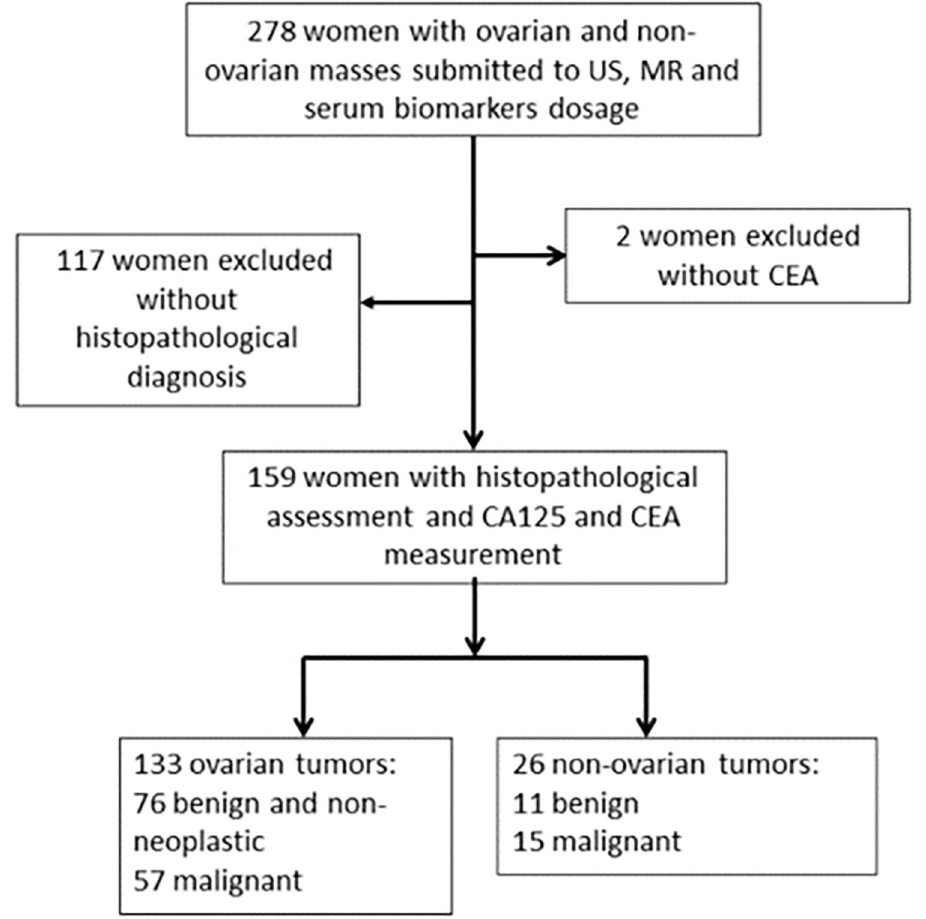
Fig 1. Flowchart describing patient inclusion and exclusion in the